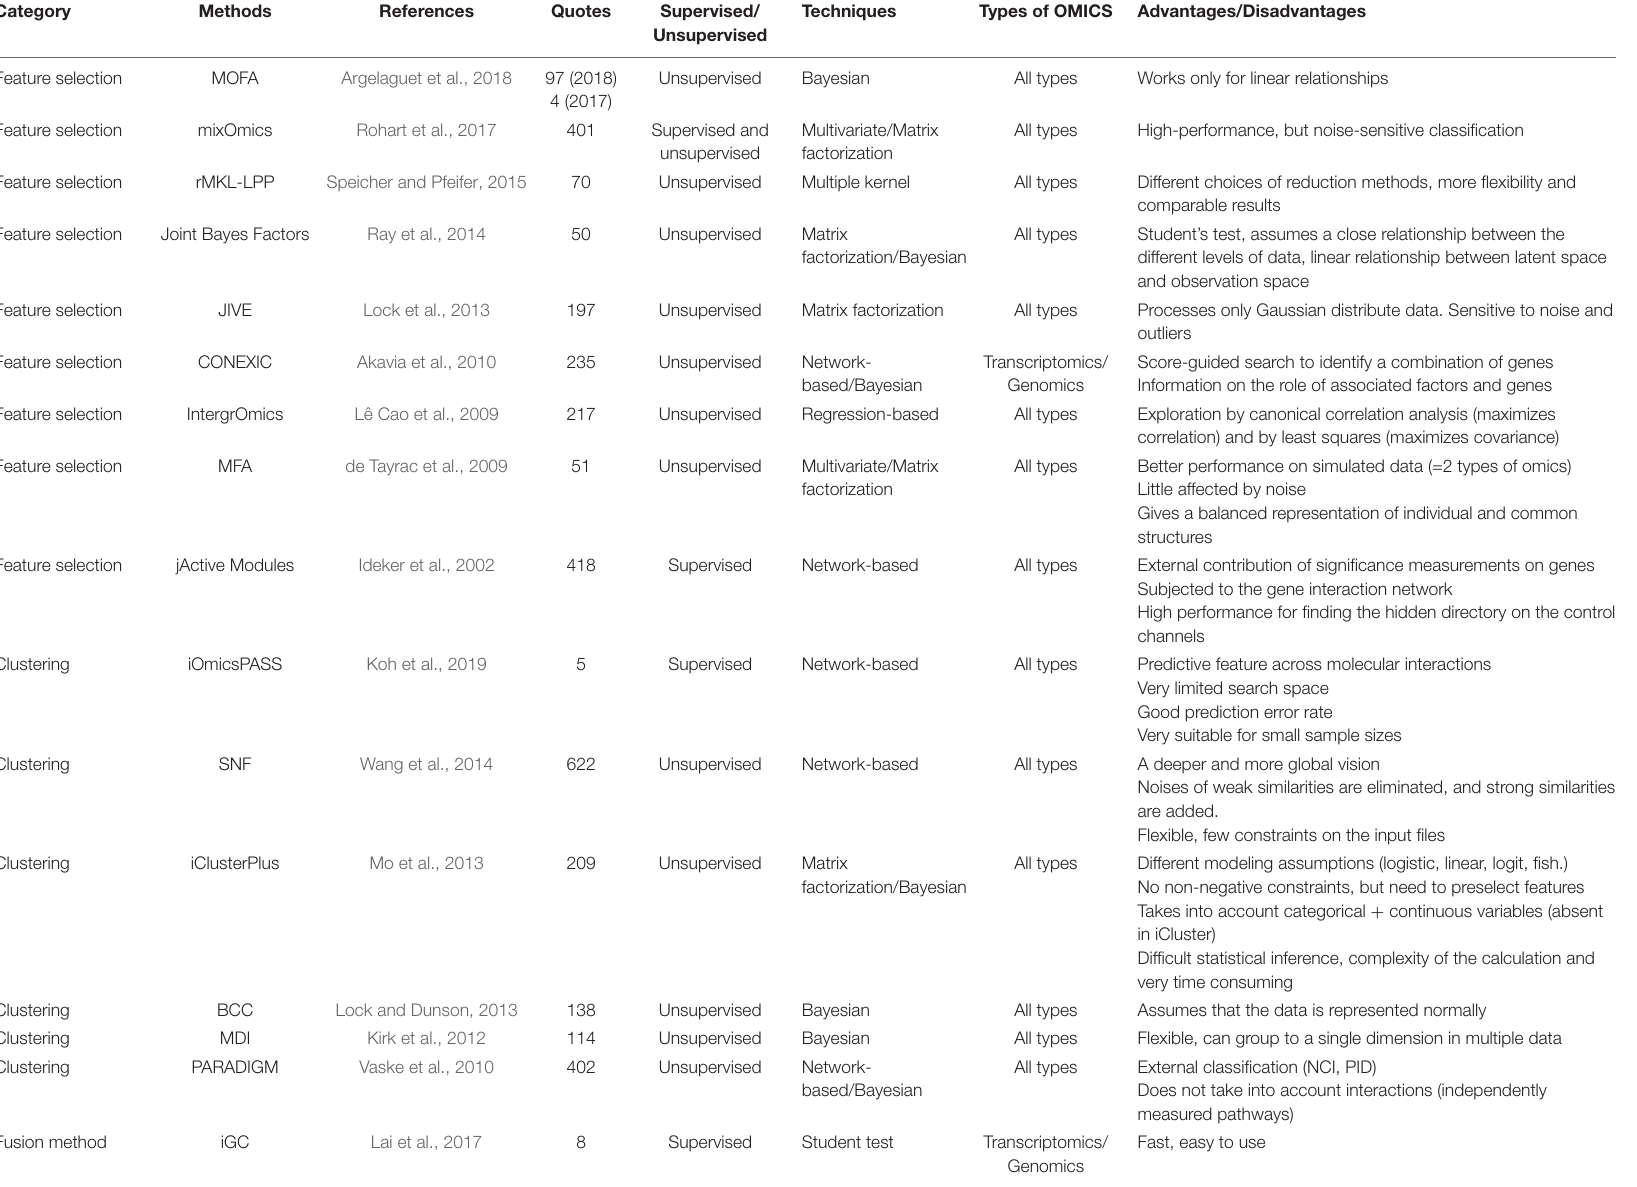
TABLE 4 | Non-exhaustive list of the main integration tools and methods grouped by the new classification and sorted by category, then by year and by decreasing number of citations.